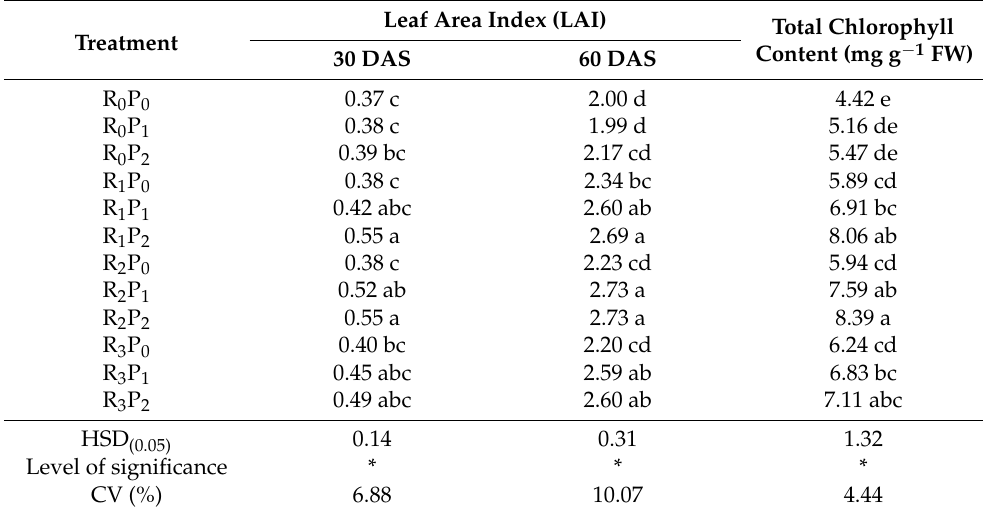
Table 3. Interaction effect of Rhizobium japonicum and Pseudomonas striata on leaf area index (LAI) and chlorophyll content of